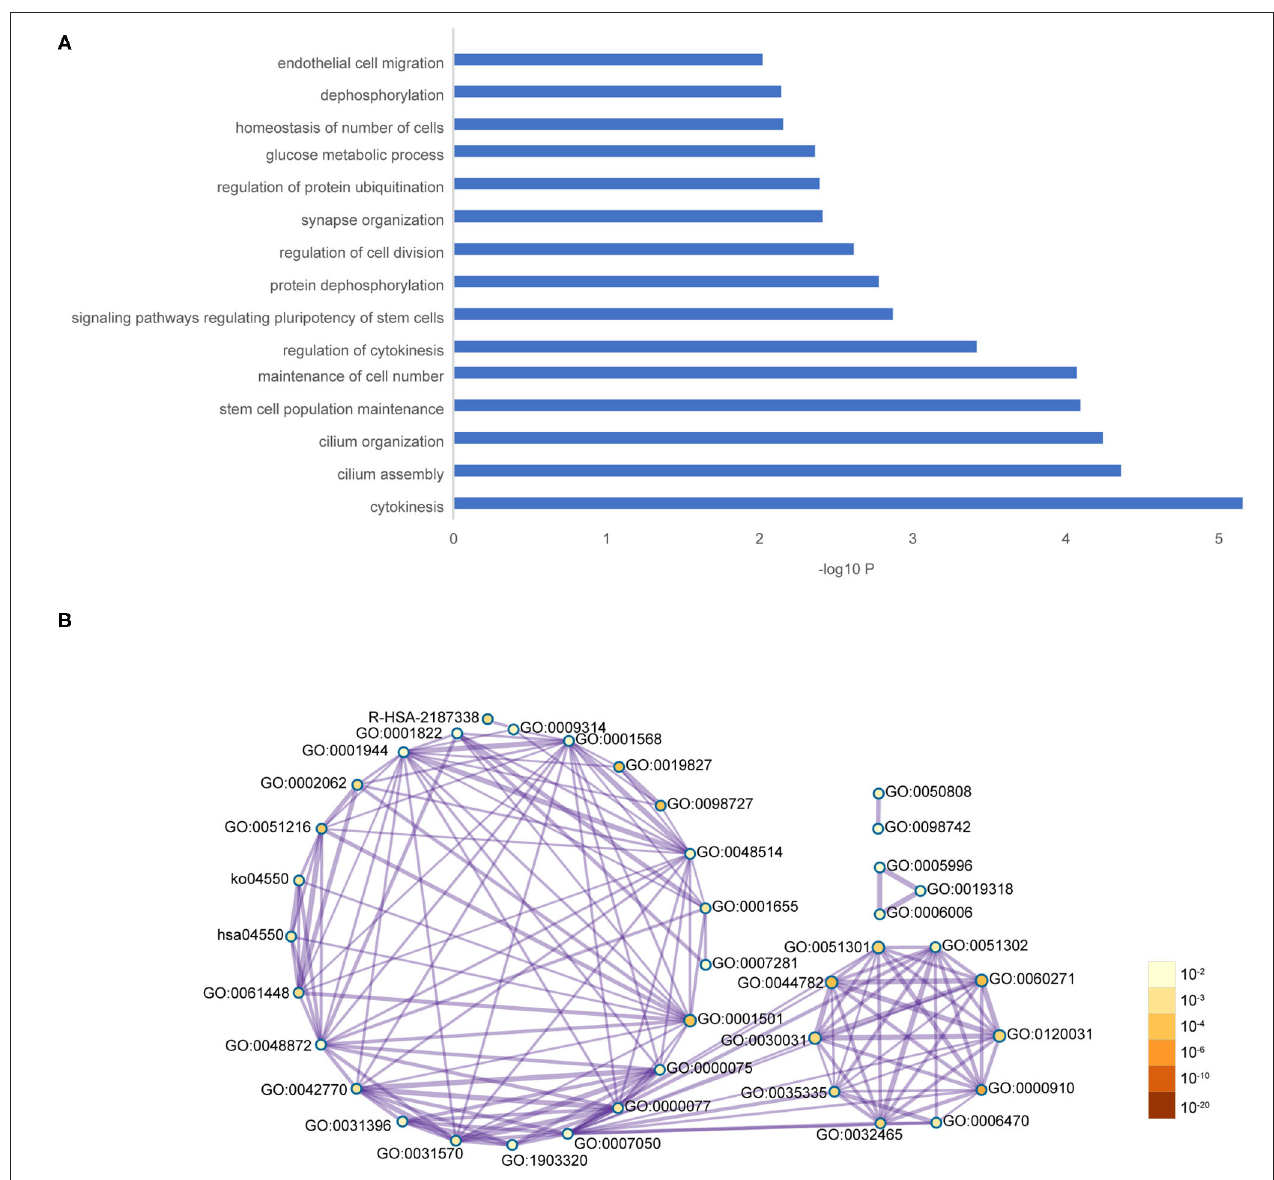
FIGURE 3 | Functional pathway enrichment of hub genes. (A) The interested pathway. (B) All of the enrichment pathway terms of hub